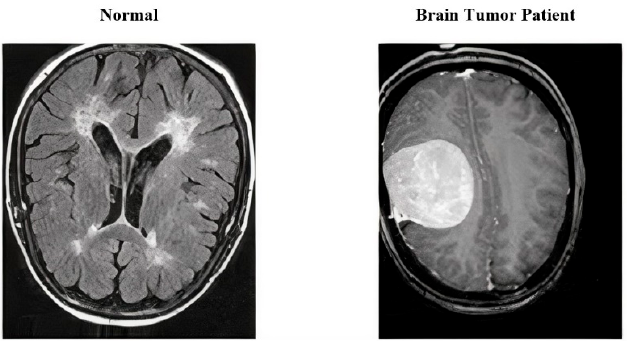
Table 1. Dataset distribution of training and testing after augmentation.